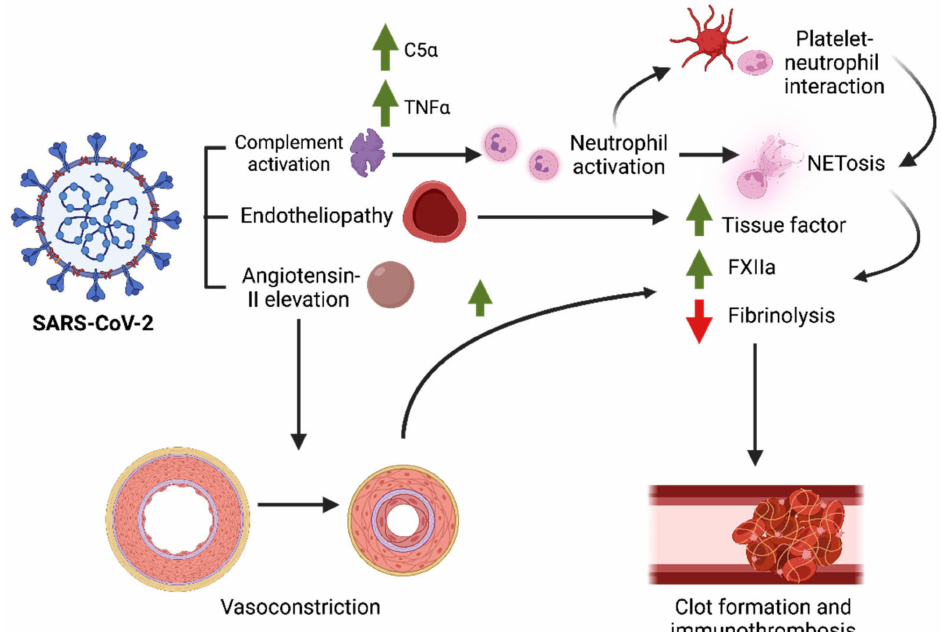
Figure 1. Mechanisms of SARS-CoV-2-induced thrombosis in severe COVID-19. The binding of spike protein to the ACE2 receptor site indirectly triggers several downstream events, including the activation of the complement pathway, endothelial injury, and vasoconstriction. Complement proteins activate neutrophils, which then release neutrophil extracellular traps (NETs) that act as a platform for contact activation of the coagulation cascade. Vasoconstriction secondary to elevated angiotensin-II promotes clot formation, which eventually lead to site-specific thrombosis in severe COVID-19. It is important to note that, although NETosis also occurs in other viral infections, such as those by the Chikungunya virus (CHIKV), respiratory syncytial virus (RSV),